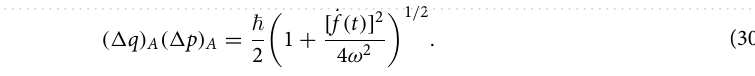
Figure 6. Density plots for the time evolution of W where the considered time is represented in each panel. The nonstaticity parameters chosen here are ( c 1 , c 2 ) = (5, 2); this choice corresponds to that of Fig. 1B. We have 1 , which is very large compared to that in Fig. 5. All other parameters taken here chosen the amplitude as A 0 = are the same as those of Fig.